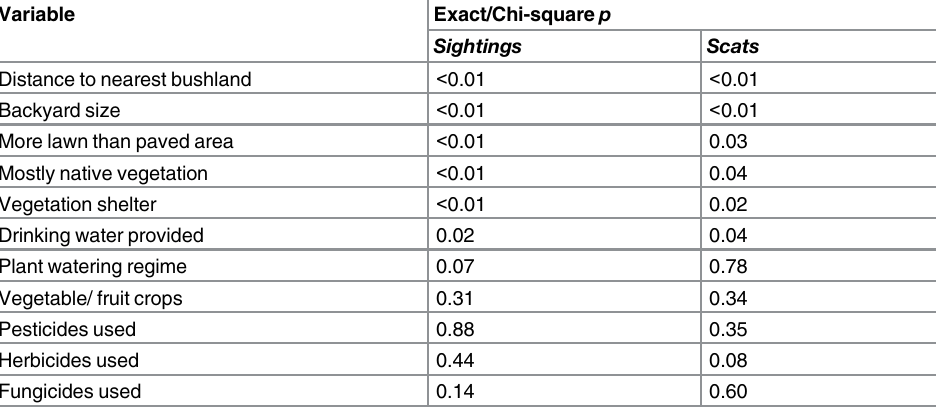
Table 2. Reports of bandicoot sightings or scats in regards to backyard variables. Results of the exact tests for each variable vs. each of the two measures (sightings and droppings) of bandicoot presence in back- yards. Values are the exact probability (significance evaluated at α = 0.05) that each contingency table would occur if that particular combination of variables were independent. Note, due to insufficient computer memory for the variable ‘ Distance to bushland ’ a Chi-square test was performed. Variable Exact/Chi-square p Sightings Scats < 0.01 < 0.01 < 0.01 < 0.01